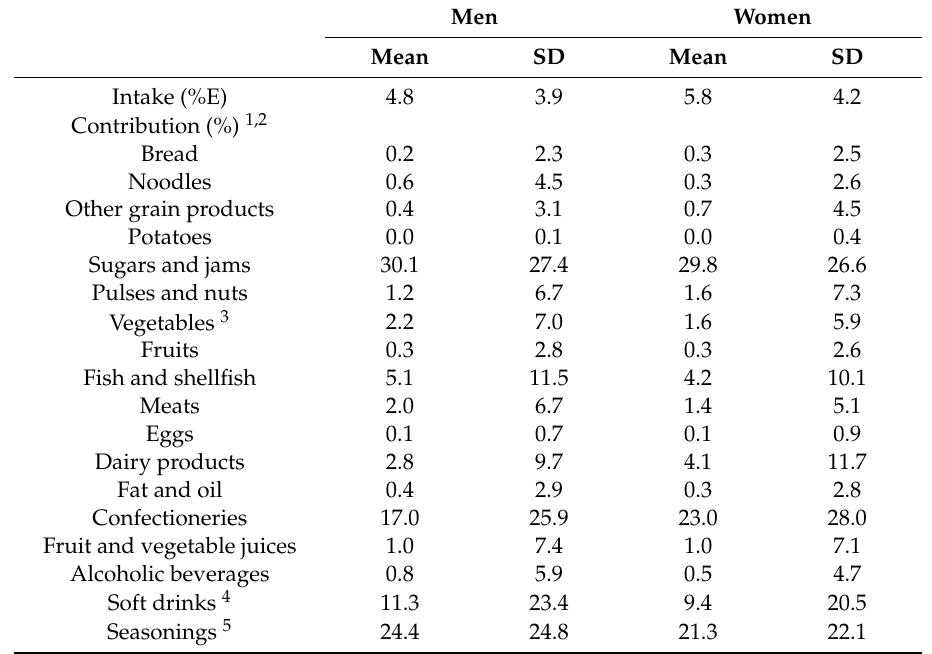
Table 1. Contribution (%) of each food group to free sugars intake in Japanese men ( n = 4071) and women ( n = 5794): the 2016 National Health and Nutrition Survey,